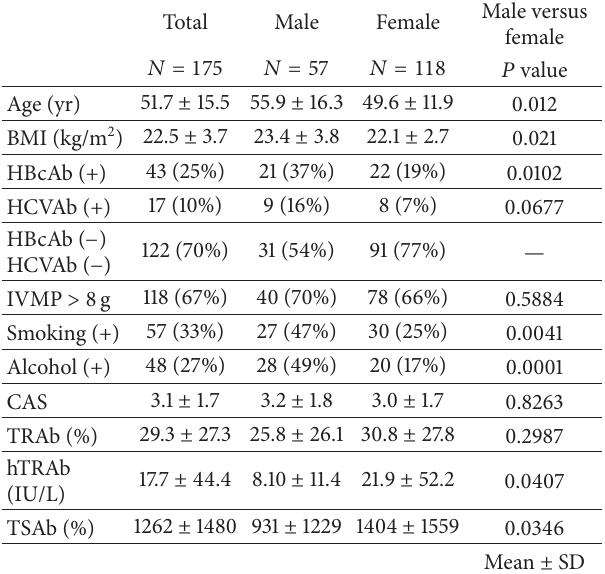
Table 1: Clinical characteristic of patients with Graves’